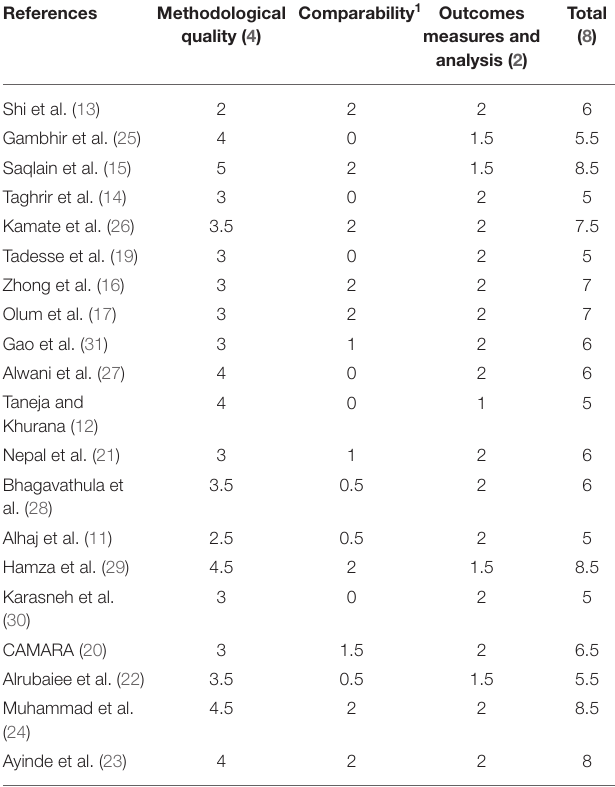
TABLE 1 | Quality assessment of included studies using Newcastle-Ottawa